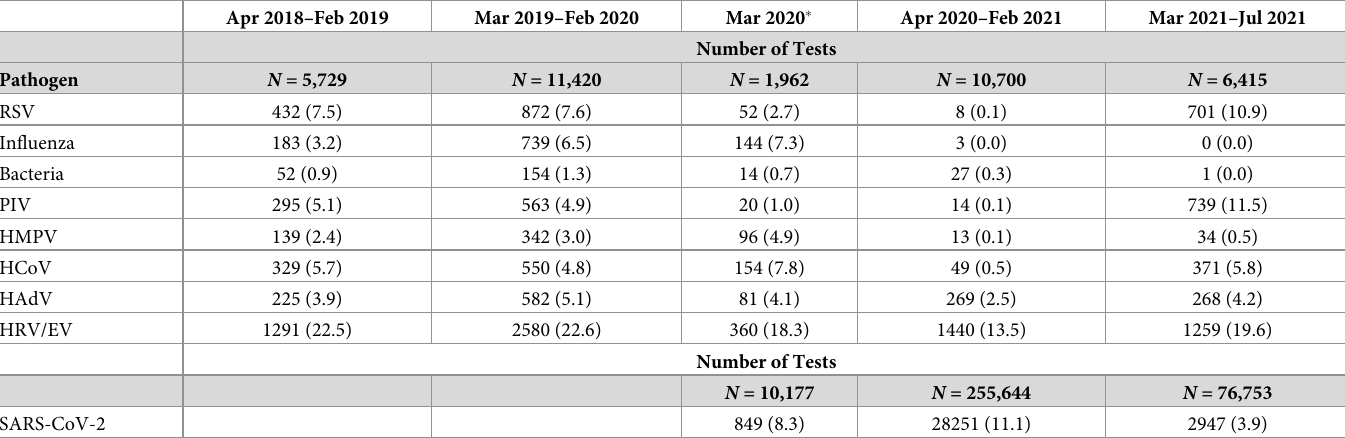
Table 1. Total number of tests stratified by time period and respiratory